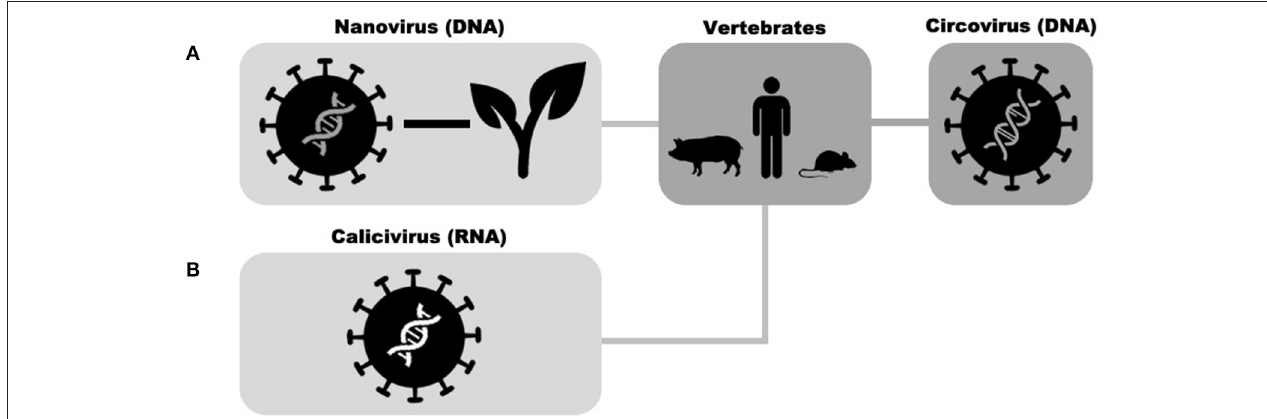
FIGURE 2 | Simplified model of circovirus evolution. Gibbs and Weiller (1999) report protein phylogeny analysis evidence for host switching of a virus from a plant to an unknown vertebrate. (A) A plant DNA virus, of the nanovirus family, host switches to a vertebrate, resulting in circovirus lineages. (B) Subsequently, a circovirus recombines with an RNA virus, of the calicivirus family, possibly via a reverse transcriptase from a retrotransposon or